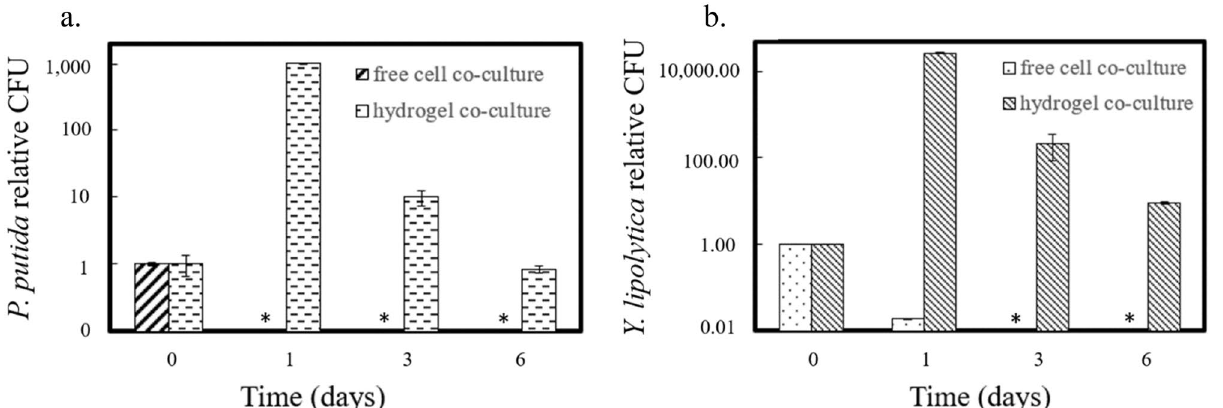
Figure 3. Relative heterotrophic cell population change in a stressful environment with high temperature and antibiotics. CFU values were normalized to the count at day 0. ( a ) Relative CFU counts of P. putida over 6 co-culture days. ( b ) Relative CFU of P. putida over six co-culture days. All data are averages of biological duplicates ± standard deviation. Some error bars are too small to see. Asterisks indicate no colony growth on